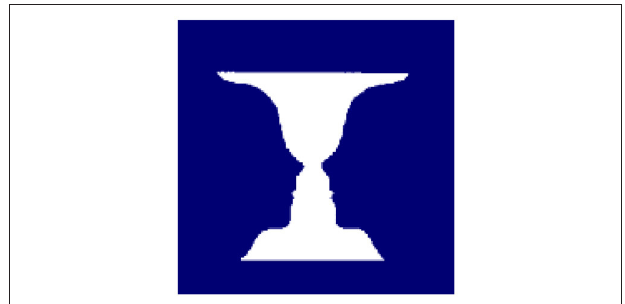
FIGURE 1 | Plain Rubin’s vase (https://psychology.wikia.org/wiki/Rubin_ vase---retrieved 6/6/2020).